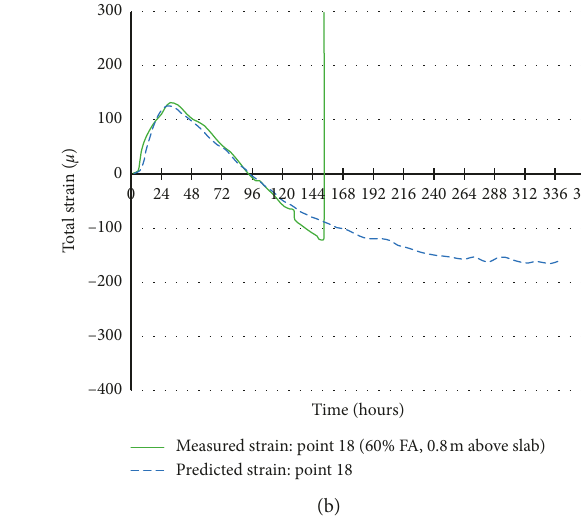
17–400 Measured strain: point 17 (60% FA, 0.4m above slab) Predicted strain: point